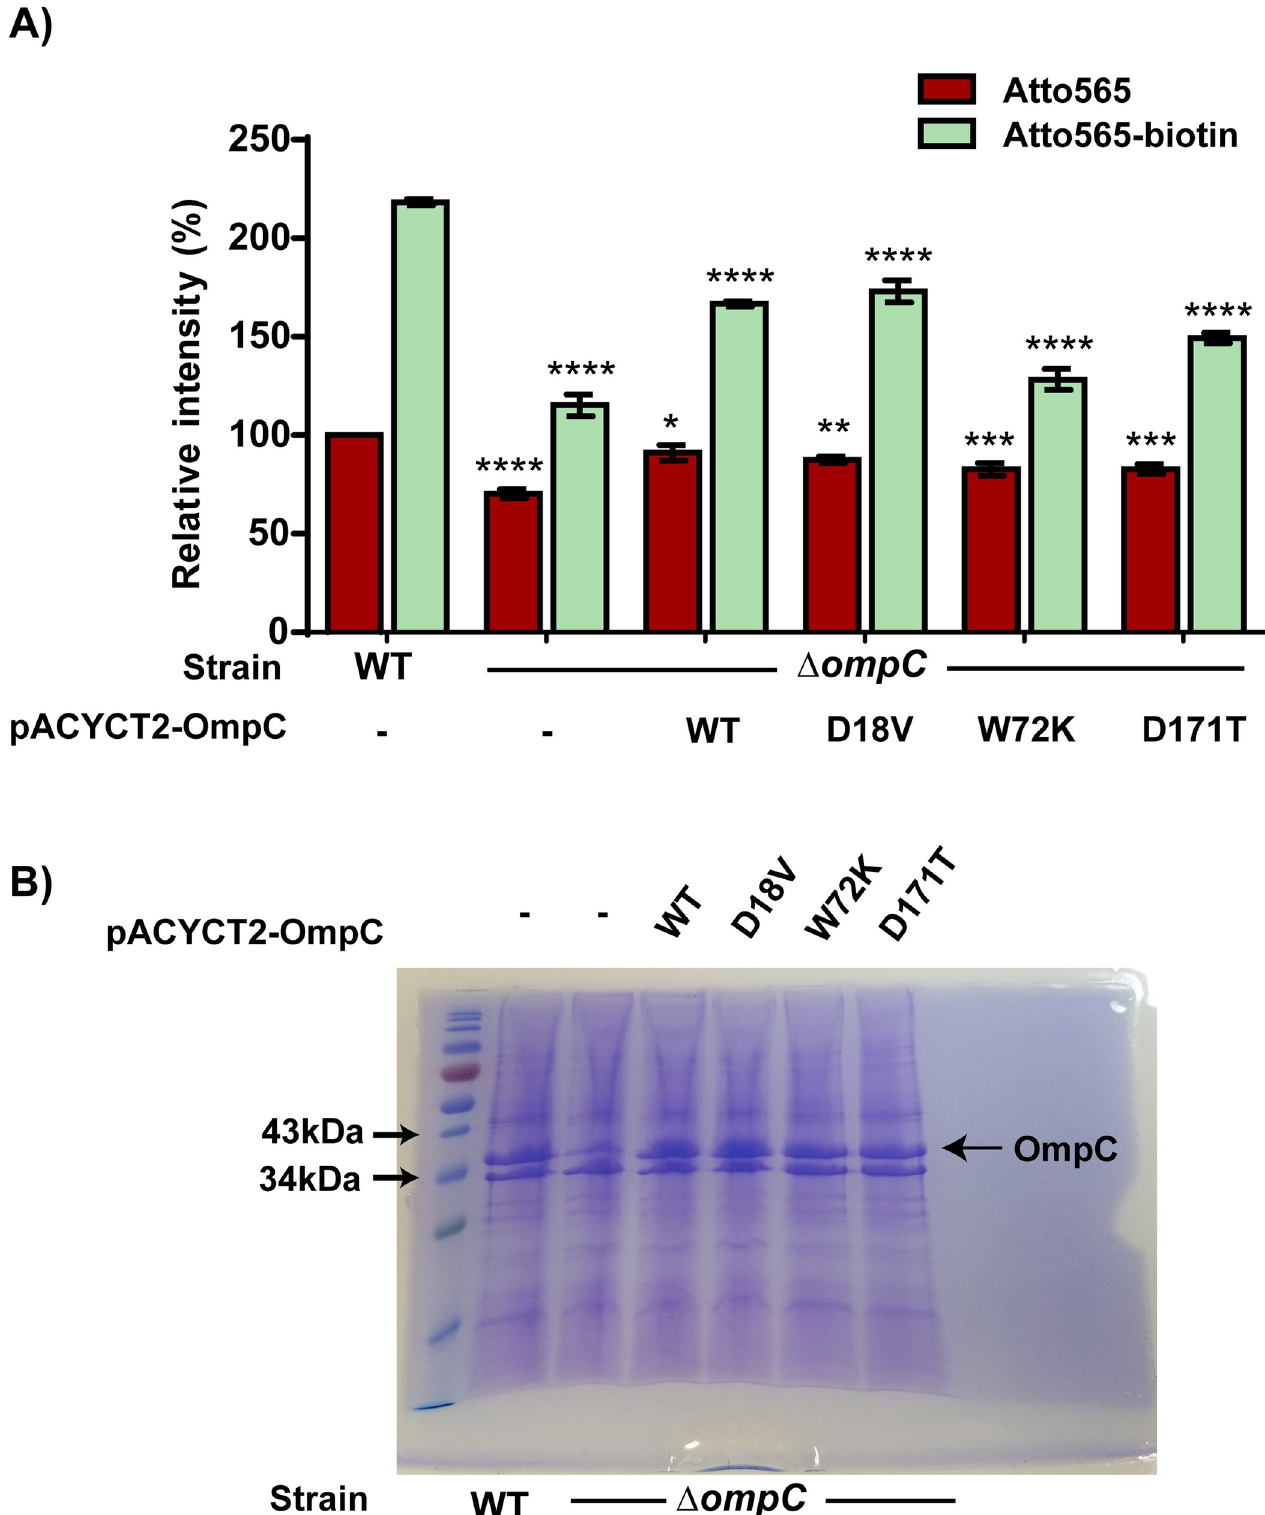
Fig 6. Accumulation of Atto565 and Atto565-biotin upon plasmid complementation of wild type OmpC as well as OmpC with different single mutations. Figure shows the representative data from three independent experiments. Data were represented as mean ± S.D. (Two-way analysis of variance;